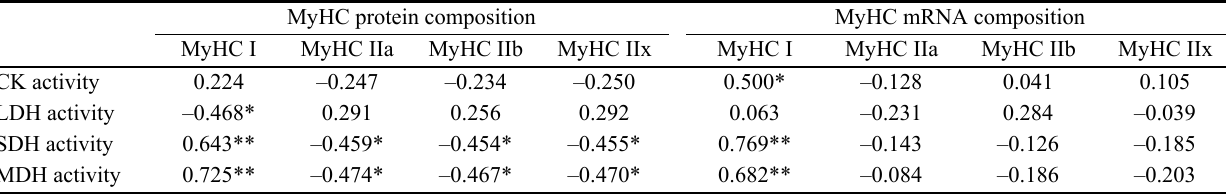
Table 5. Correlations of MyHC composition with metabolism enzyme activities in porcine LM during postnatal growth MyHC protein composition MyHC mRNA